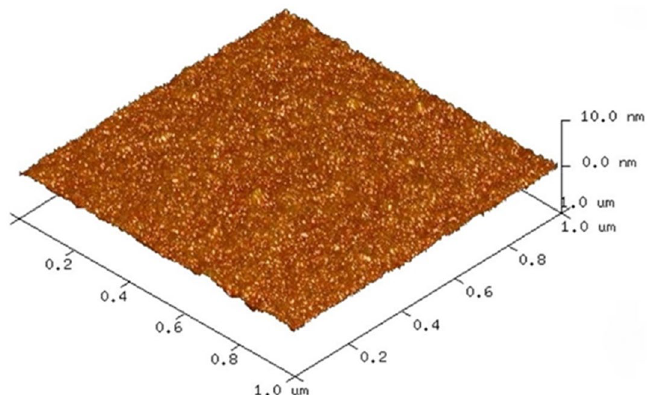
Figure 1. AFM image of the deposited Al 2 O 3 thin film using ALD method.